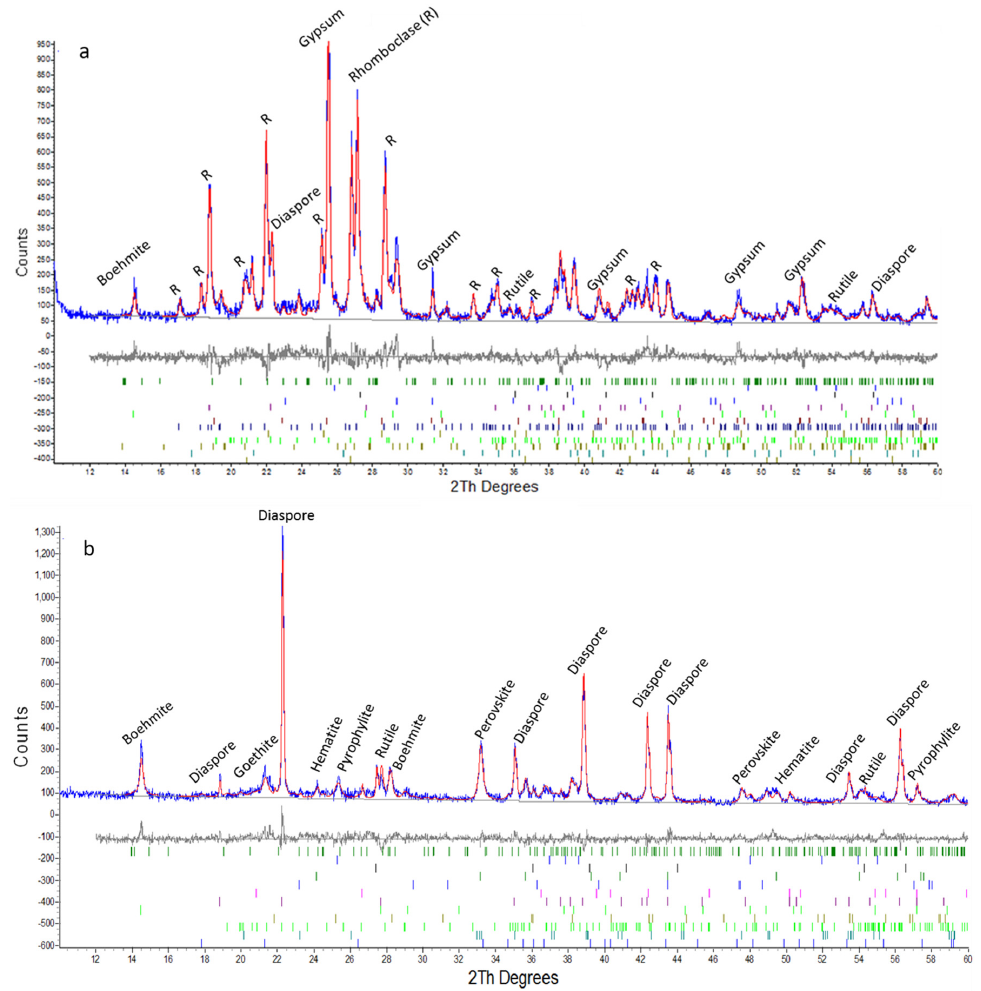
Figure 2. X-ray Diffraction (XRD) analyses of solid residues at the end of 2 h: ( a ) H 2 SO 4 and ( b ) HCl leaching with Rietveld refinement (blue line is experimental, red line is calculated and the difference below with marked reflection positions).